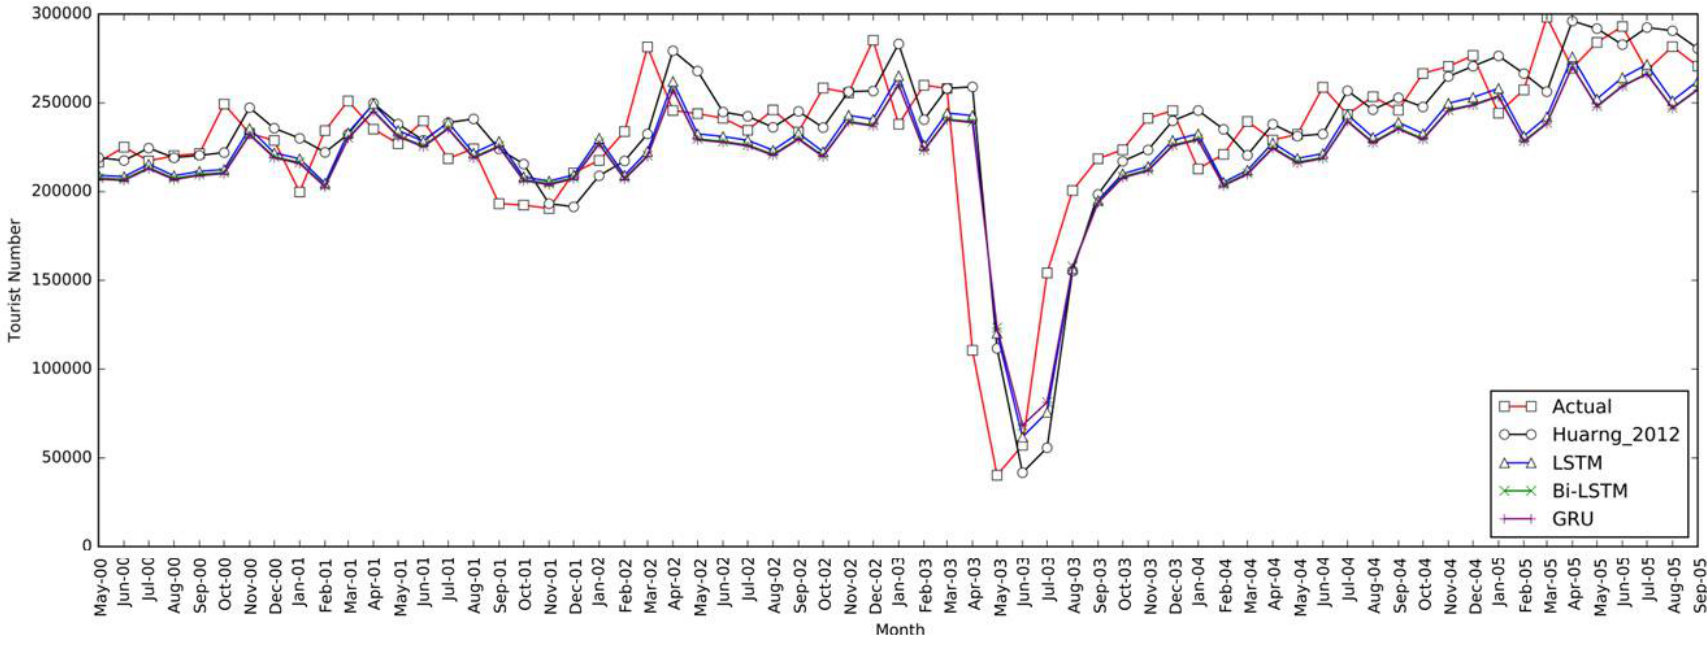
Figure 4. The actual and predicted tourist number of Taiwan from May 2000 to September 2005.